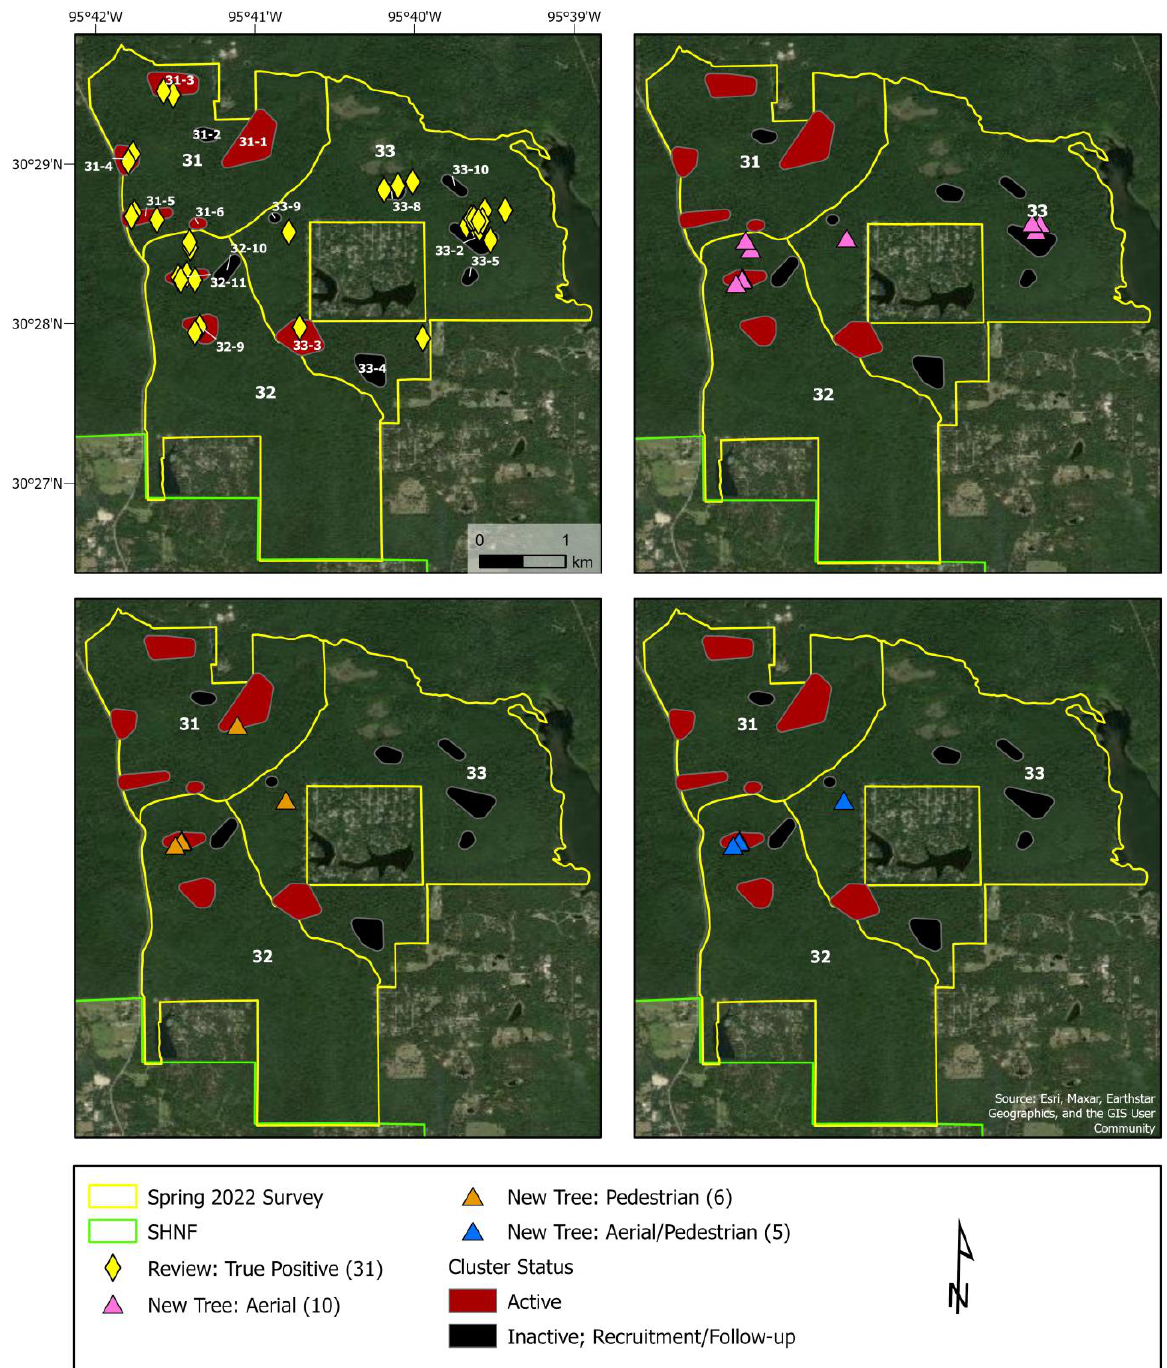
Figure 8. Map of the aerial and pedestrian survey results for new RCW cavity trees in Compartments 31–33 on SHNF. Aerial surveys detected five unique trees and discovered existing trees in six of eight active cluster sites. Pedestrian surveys discovered one unique tree, and both methods detected five of the same new trees. This ultimately resulted in ten new trees discovered by the UAS, six during traditional pedestrian surveys, and eleven total using both methods. Coordinate System: NAD 1983 UTM Zone 15N. Our basemap was reprinted/adapted with permission from Ref. [38]. Maps throughout this article were created using ArcGIS® software by Esri. ArcGIS® and ArcMap™ are the intellectual property of Esri and are used herein under license. Copyright © Esri. All rights reserved. For more information about Esri® software, please visit www.esri.com.